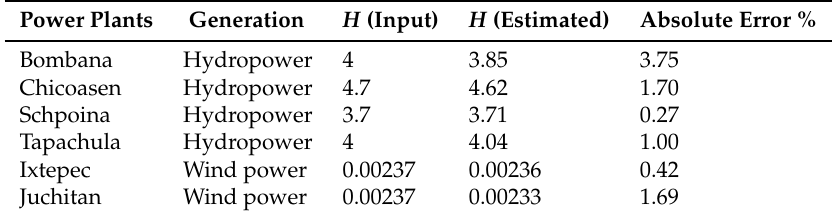
Table 4. Inertia estimation results, generation trip